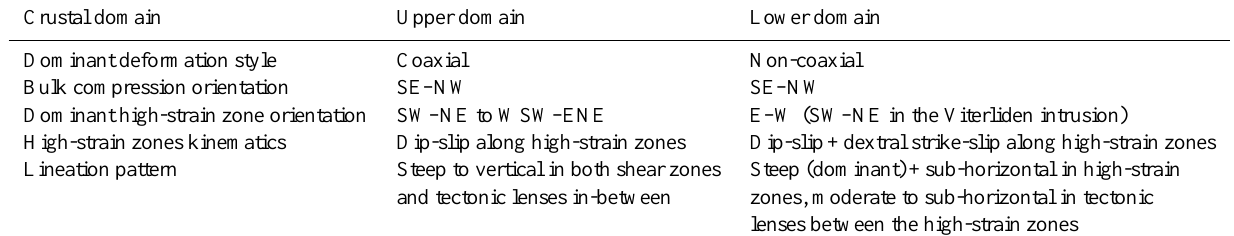
Table 1. Summary of the tectonic domains and their characteristic structural features.